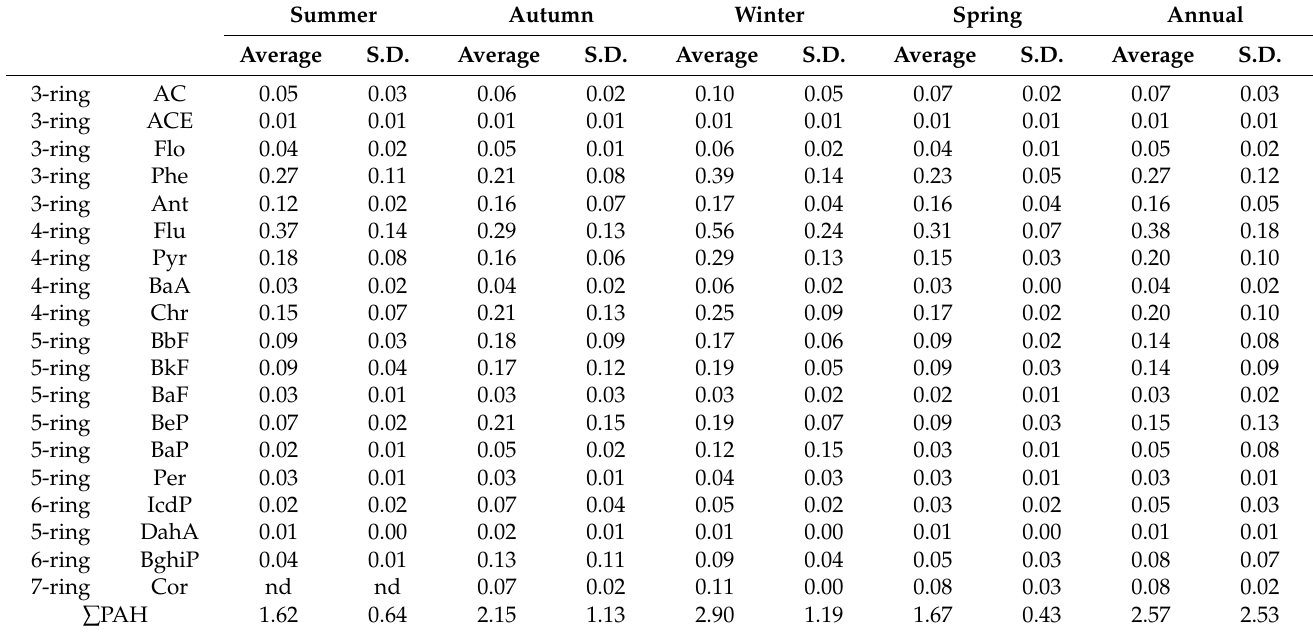
Table 1. Mass concentration of PAH components (ng/m 3 ) in PM 2.5 at TC, Hong Kong. Summer Autumn Winter